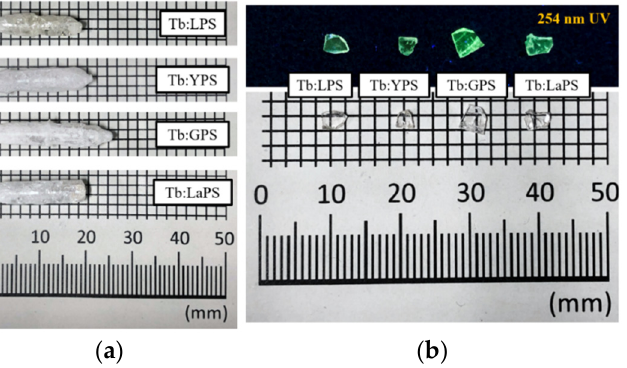
Figure 1. Tb-doped LPS, YPS, GPS, and LaPS samples photographs of ( a ) as-grown single crystal rods; ( b ) cut and polished specimens in room light and 254 nm UV.